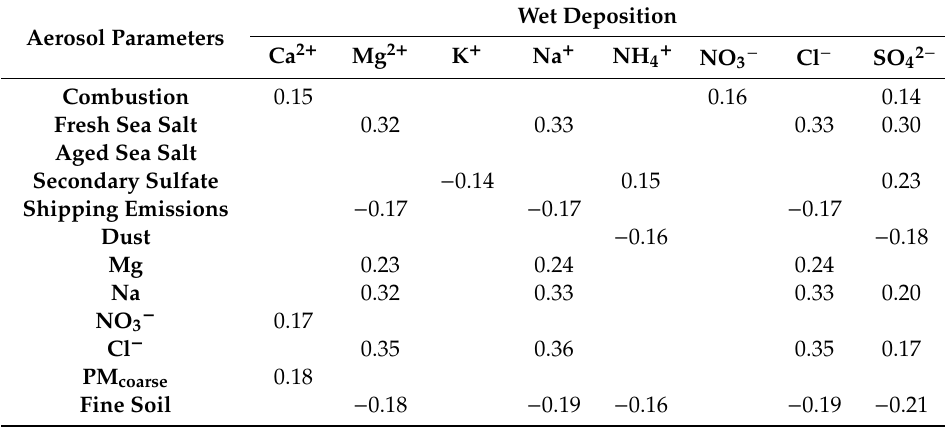
Table 2. Correlation coe ffi cient (r) matrix between precipitation (NADP) and aerosol (IMPROVE) composition data. Values shown are statistically significant at the 95% confidence level. The first six aerosol parameters are concentrations of PMF source factors, while the final six at the bottom are selected IMPROVE parameters relevant to the discussion in Section 3.4. Coarse particulate matter (PM coarse ) is calculated as particulate matter with a diameter less than or equal to 10 µ m (PM 10 )–particulate matter with a diameter less than or equal to 2.5 µ m (PM 2.5